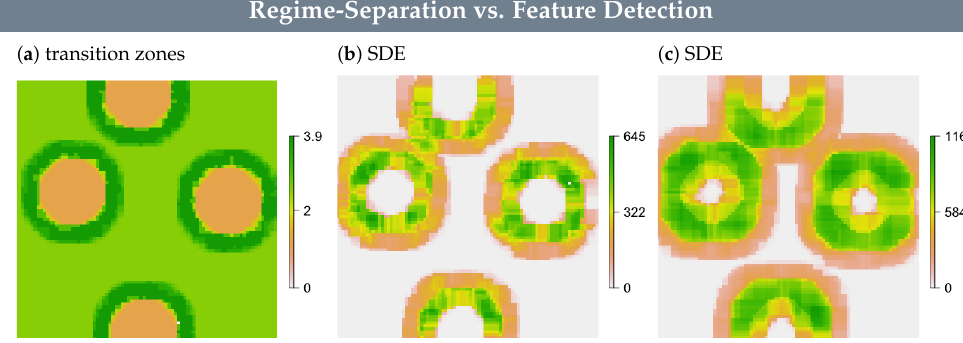
Figure 8. ( a ) Random patches surrounded by transition zones, ( b ) structural diversity entropy (SDE), δ = 2, inner scale WSL I 7, outer scale D , ( c ) SDE, δ = 2, inner scale WSL I 13, outer scale D